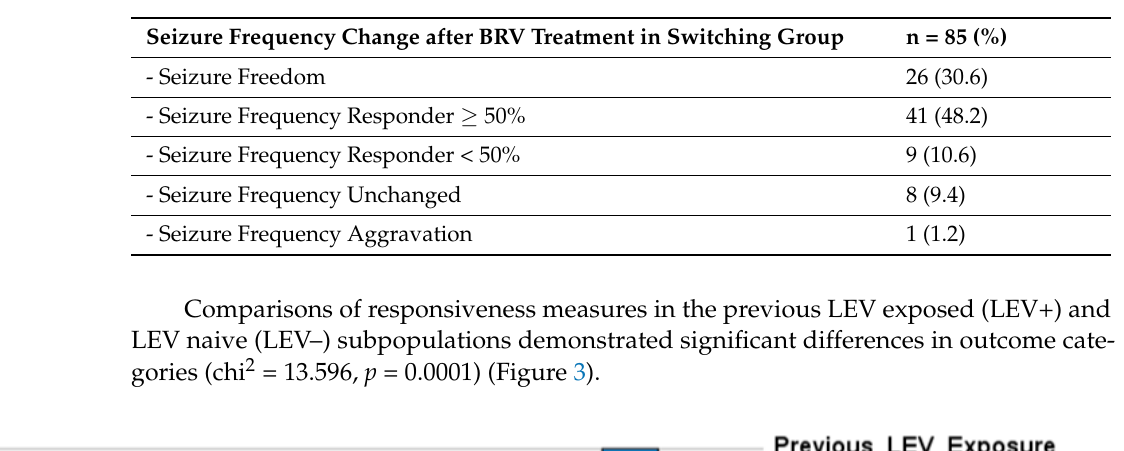
Table 4. BRV response after switching from LEV treatment.